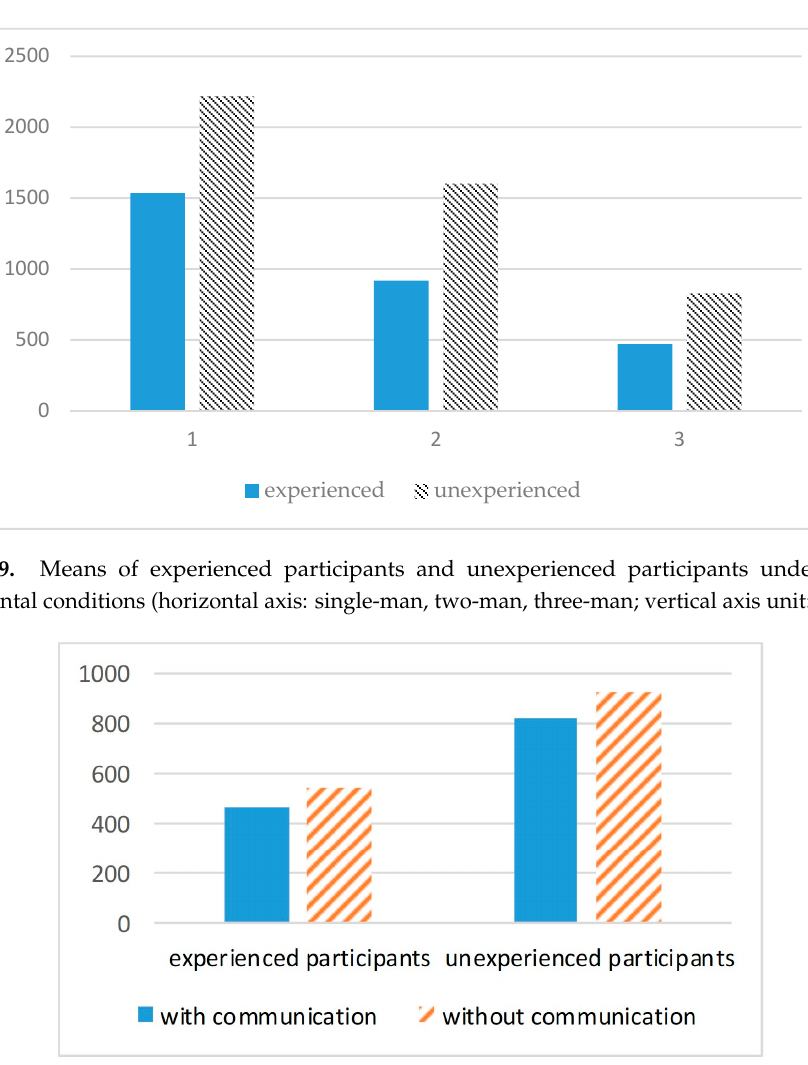
Figure 20. Mean of three-man teams with voice communication/without voice communication under the experimental conditions (horizontal axis: experienced/unexperienced participants; vertical axis unit: seconds).